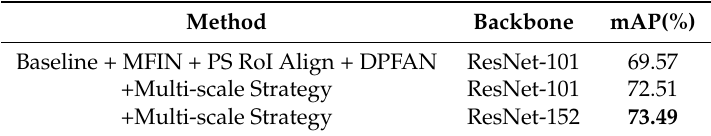
Table 6. The ablation study for the multi-scale strategy. The numbers in boldface indicate the best performance.